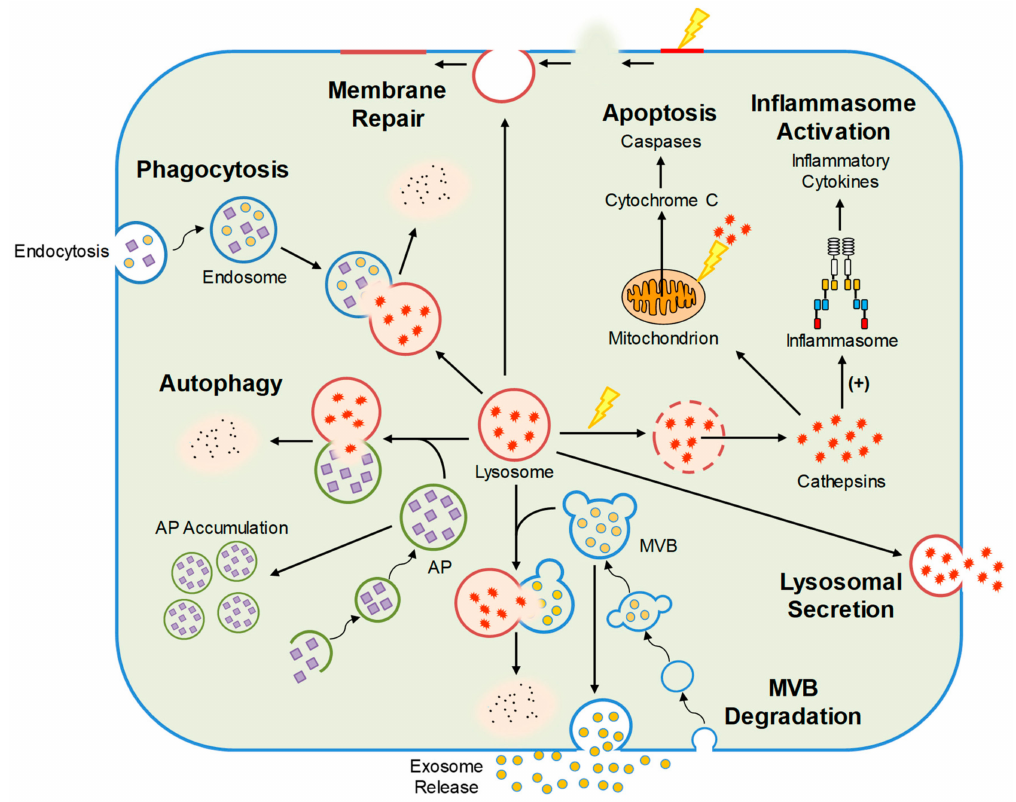
Figure 1. Cellular functions regulated by lysosomes including autophagy, MVB degradation, lysosomal secretion, phagocytosis, inflammasome activation, membrane repair, and apoptosis. AP, autophagosome; MVB, multivesicular